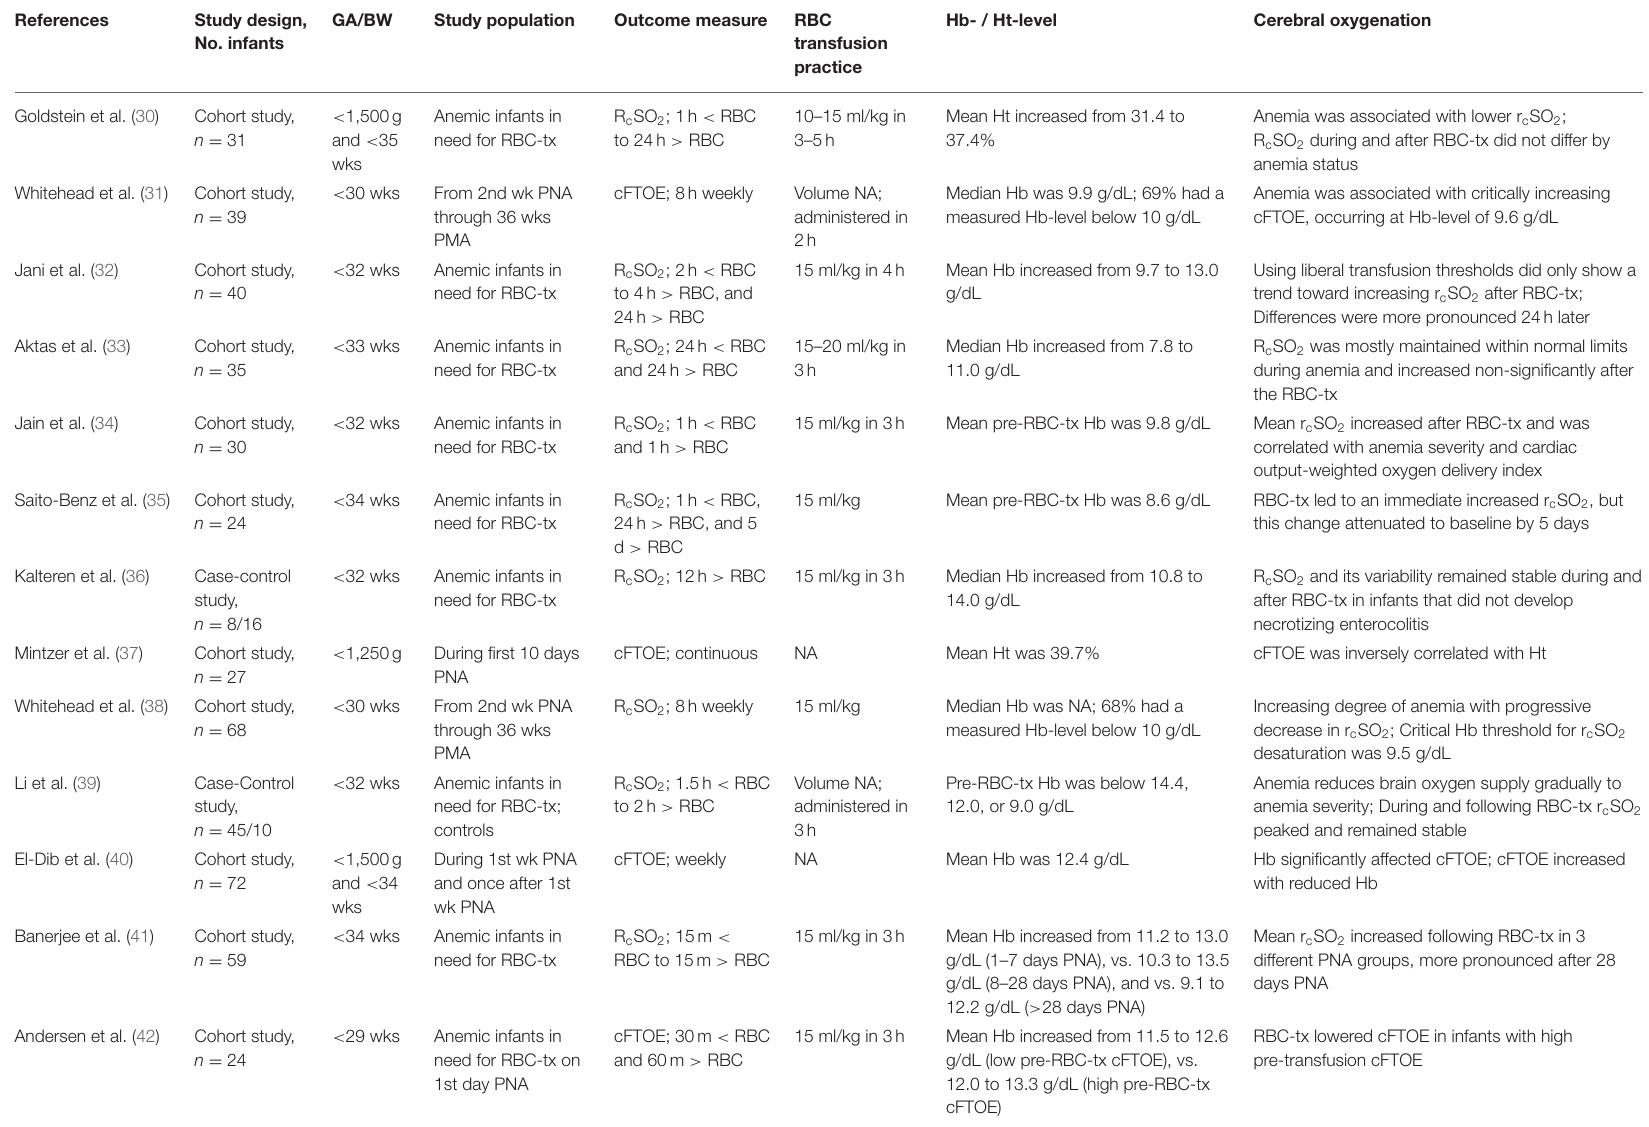
TABLE 1 | Results of selected studies on cerebral tissue oxygenation, measured by